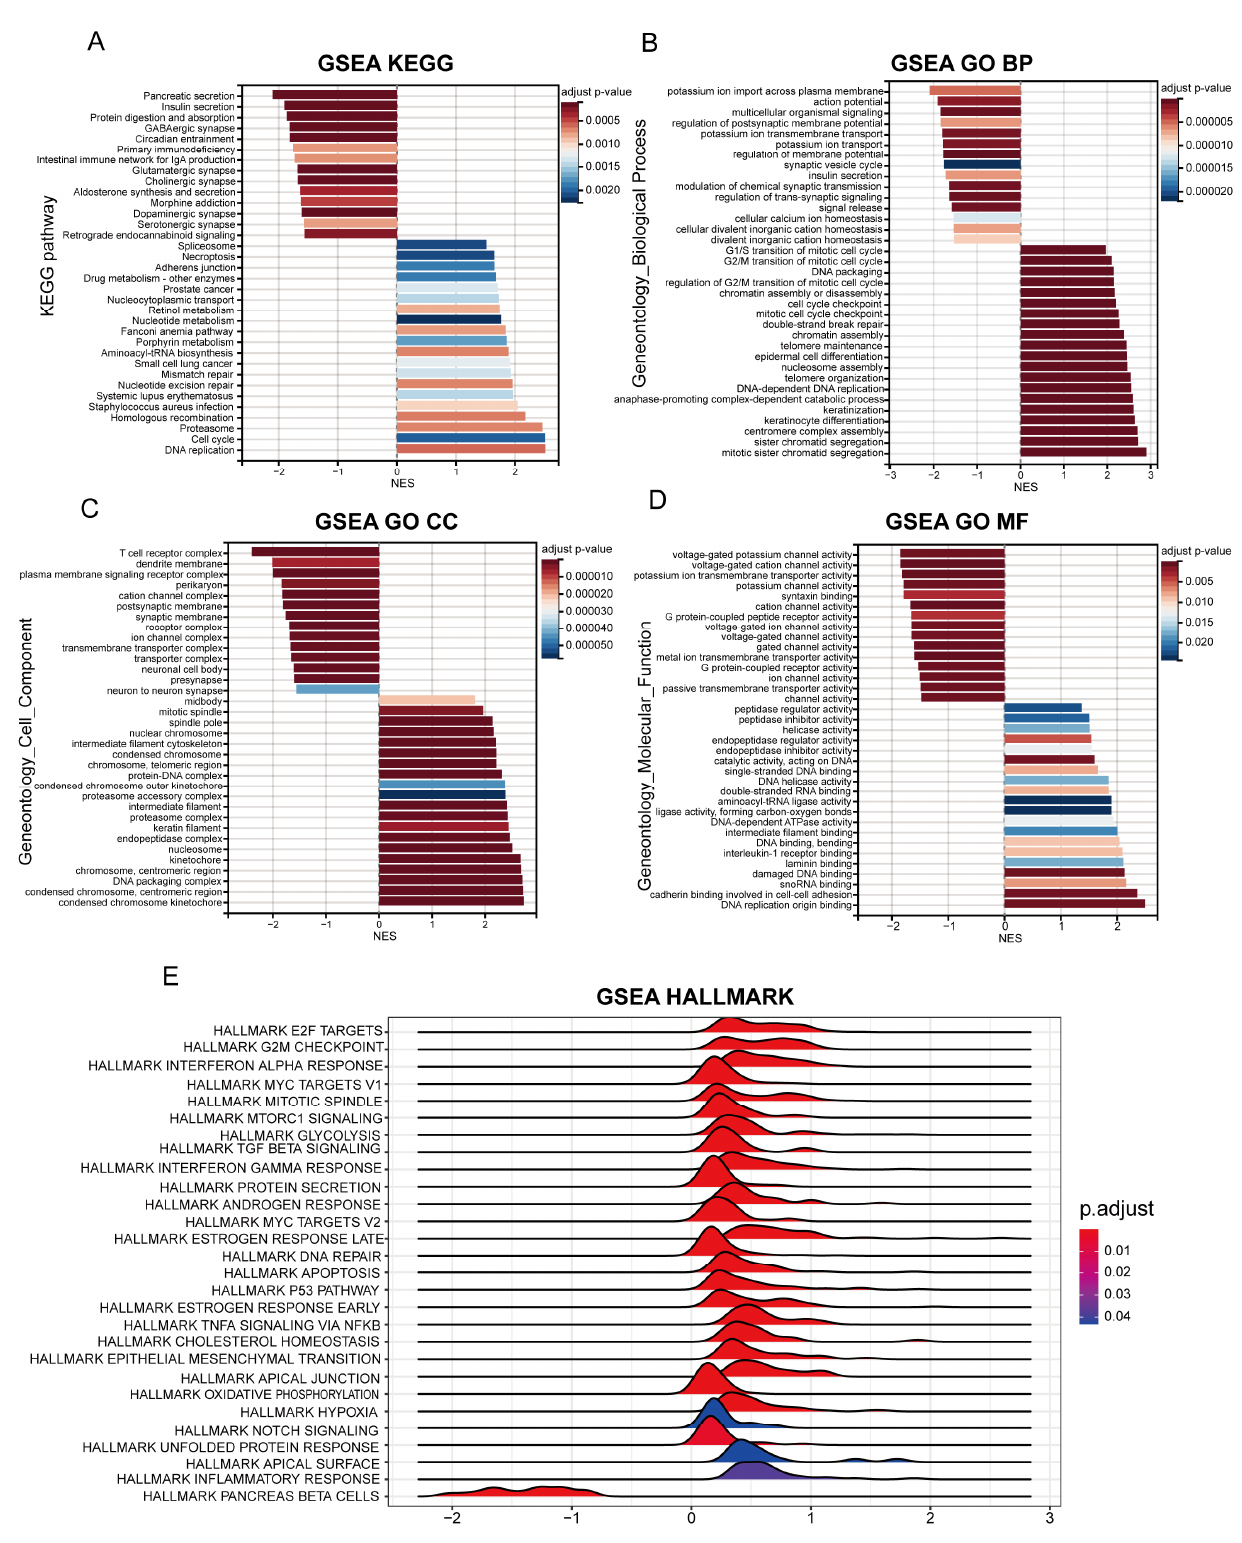
Figure 5. Gene set enrichment analysis (GSEA) between the high- and low-risk groups. ( A ) The KEGG pathway enrichment analysis. ( B – D ) The GO enrichment analysis including the biological process (BP), cellular component (CC), and molecular function (MF). ( E ) The HALLMARK gene set enrichment analysis. Note: p < 0.05 was considered statistically significant.